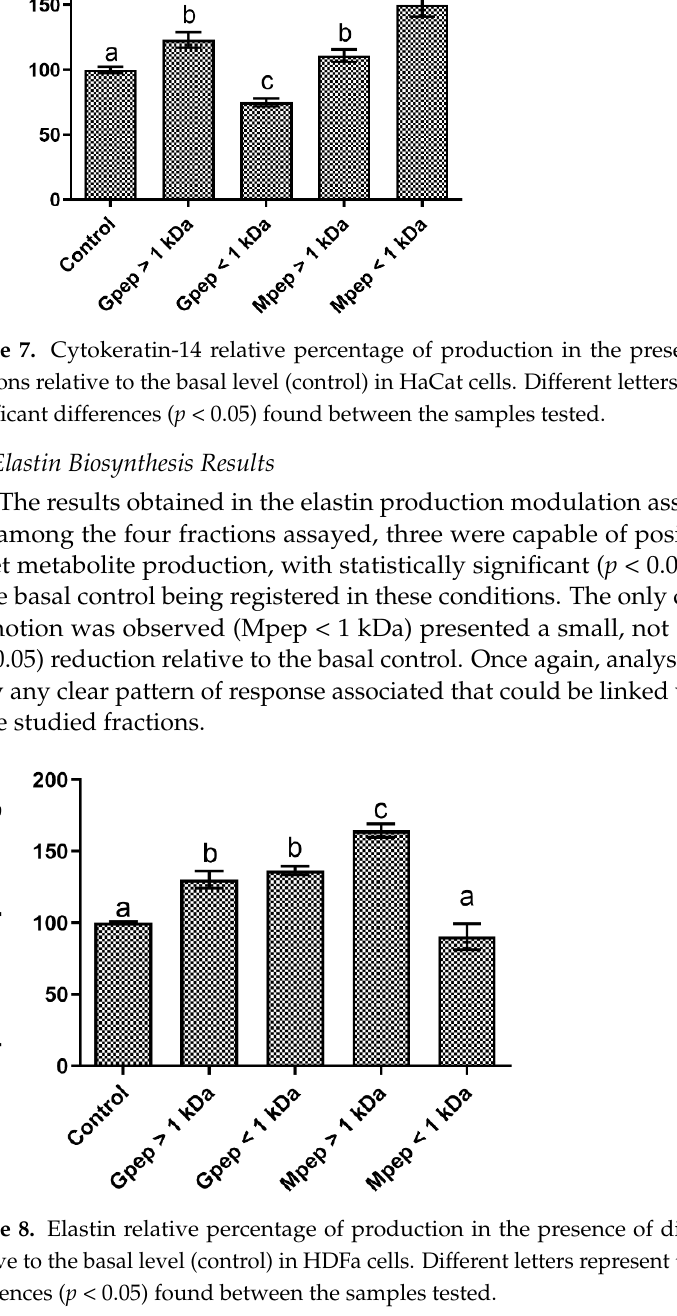
Figure 6. Fibronectin relative percentage of production in the presence of different peptide fractions relative to the basal level (control). Different letters represent the statistically significant differences ( p < 0.05) found between the samples tested.